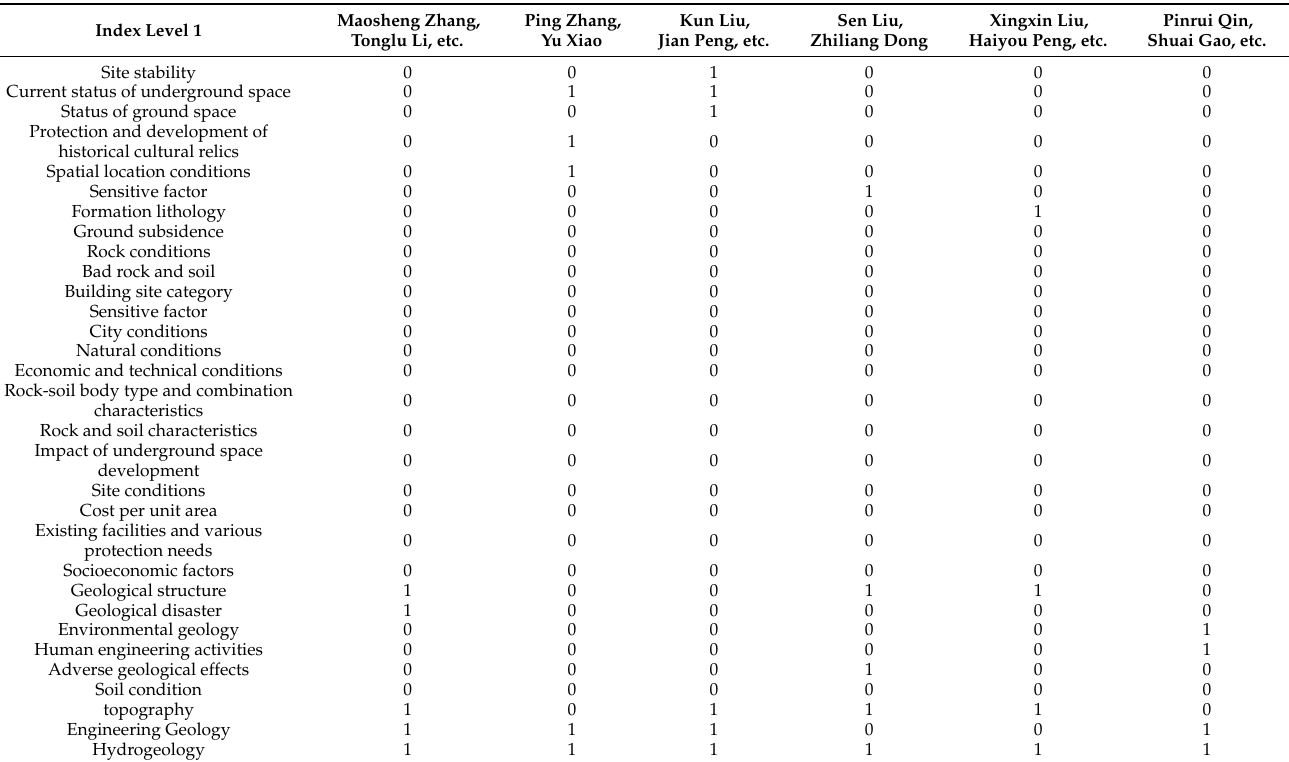
Table A1. First level index binarization